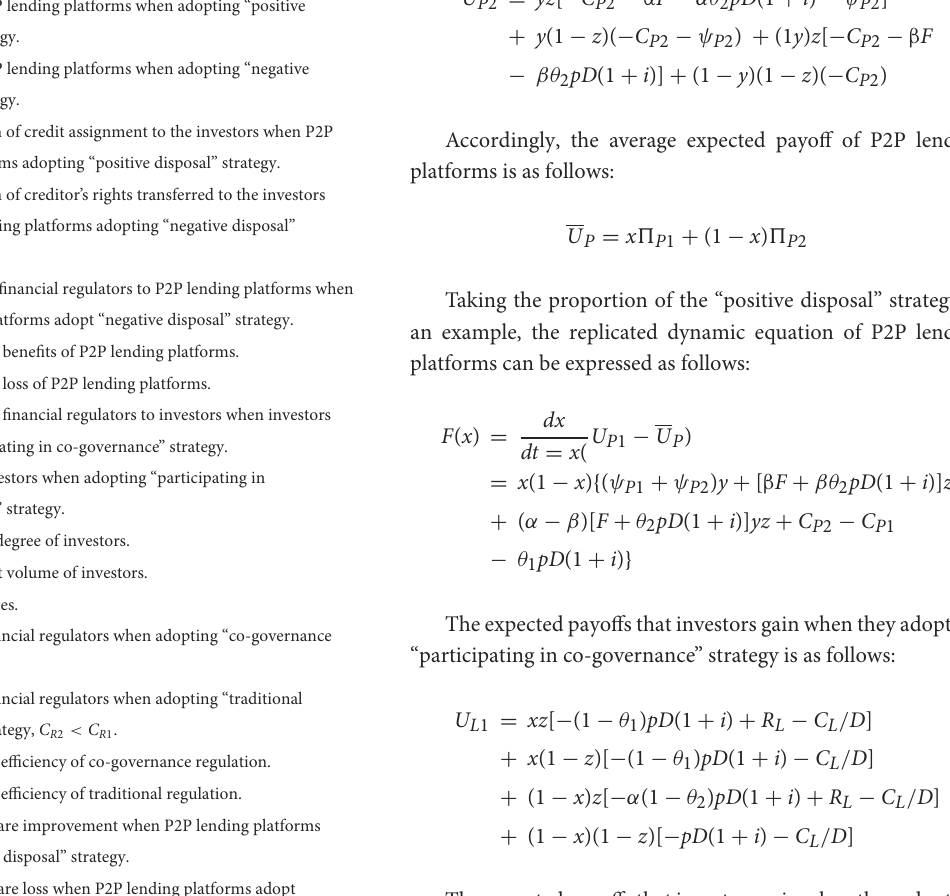
TABLE 3 Symbols and notations of the parameters in the model. Parameters